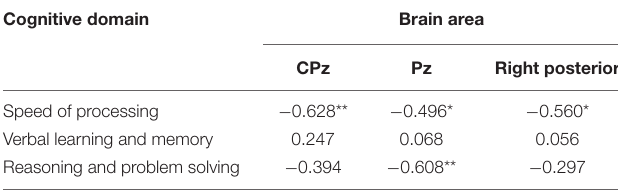
TABLE 8 | Partial correlation between cognitive domain and brain area. Cognitive domain Brain